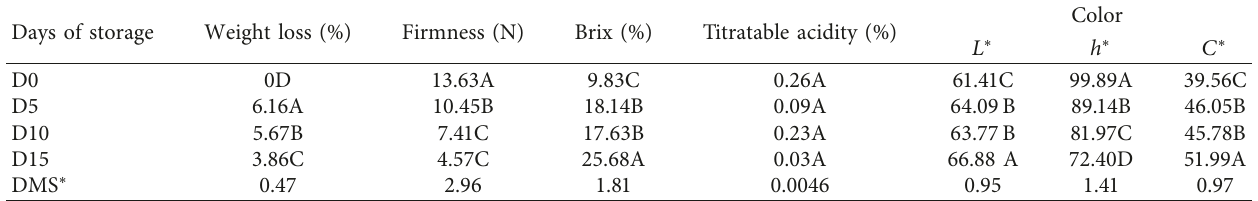
Table 1: Changes in the independent variables of stenospermocarpic mango “Ataulfo” fruit per day of storage. Days of